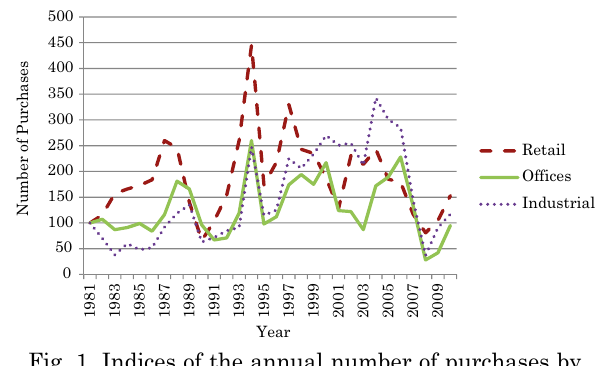
fig. 1. Indices of the annual number of purchases by investment property sector 1981–2010 (1981 = 100)